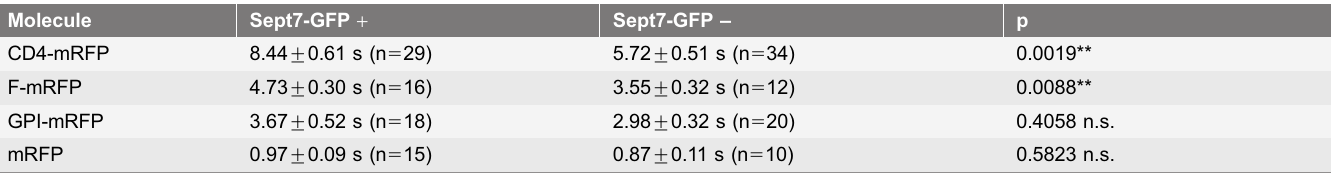
soluble mRFP (mRFP). We found that the flow of F-mRFP (p 5 0.0088), but not that of GPI-mRFP and mRFP, was reduced in Sept7-GFP positive spines (Fig. 4b, Table 2). Taken together, these results suggest that the diffusion of molecules spanning the plasma membrane and molecules anchored to the inner membrane leaflet are reduced by the presence of Sept7 at the spine neck, but cytoplasmic Table 2. Recovery times of fluorescent molecules in